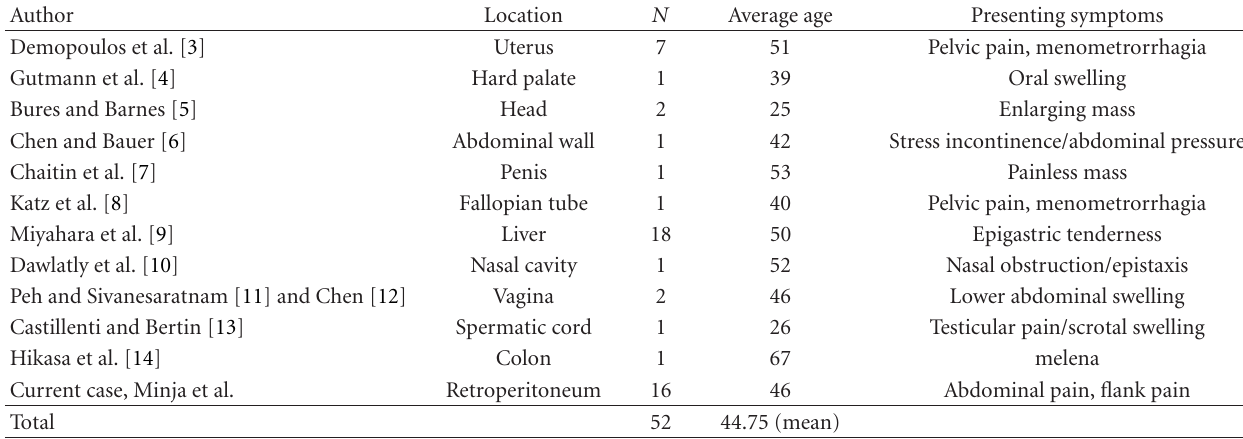
Table 1: All reported cases of extrarenal angiomyolipomas (1982–2011).